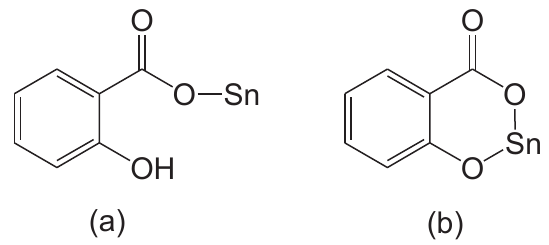
Figure 1: Coordination modes of salicylate ligand with tin atom in (a) monoanionic and (b) dianionic